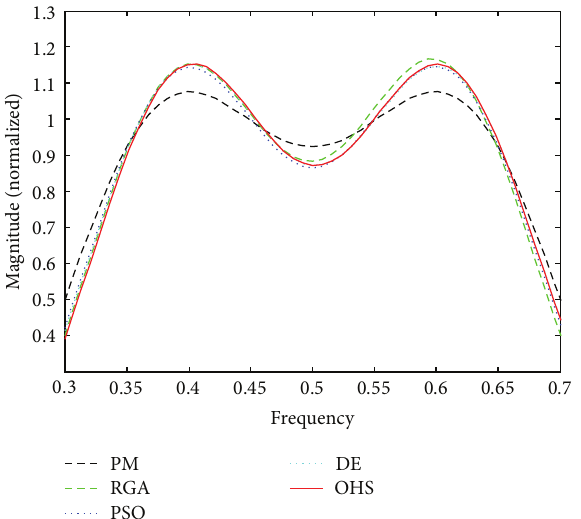
Figure 13: dB plots for the FIR BS filter of order 20.